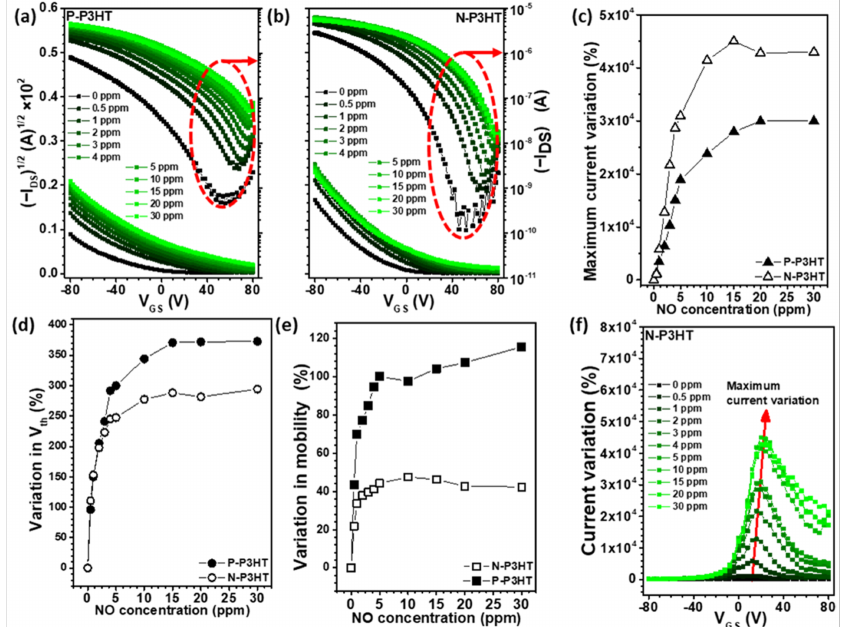
Figure 4. Transfer curves of the OFETs based on the ( a ) P-P3HT and ( b ) N-P3HT active layers. The variation in the ( c ) maximum current, ( d ) threshold voltage, and ( e ) charge carrier mobility of the N-P3HT OFET and P-P3HT OFET sensors upon exposure to various NO concentrations. ( f ) Current variation ((I ON − I 0 )/I 0 , %) over the gate voltage of the N-P3HT